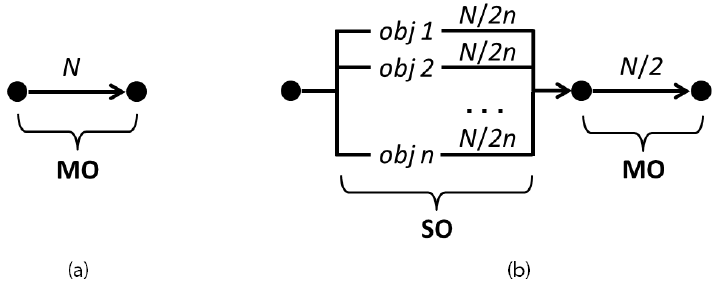
Figure 4. Allocation of the N function evaluations to the different steps of a traditional MO algorithm ( a ) and of the proposed SO+MO procedure ( b